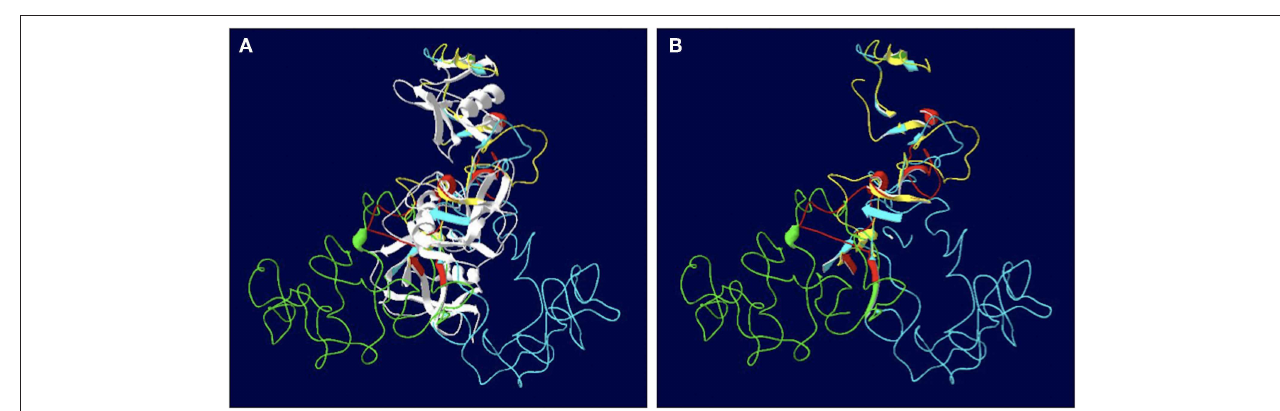
FIGURE 10 | Models of the SALSA SRCR domains. (A) Superimposition of the SRCR domains from 10 individuals. Common strands are in white, and colored strands represent different isoforms. Most alpha helices and beta sheets are common to all 10 horses. (B) Same model with common strands omitted. Variable features between are largely due to protein loops rather than alpha helices and beta